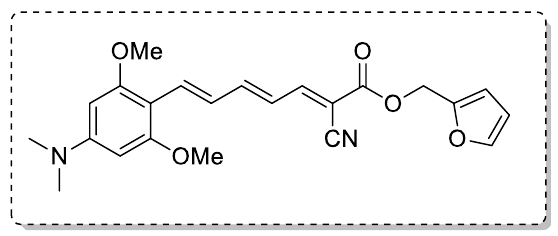
Figure 17. probe (1) with “turn - on” fluorescence . Figure 17. NIRF probe (1) with “turn-on”